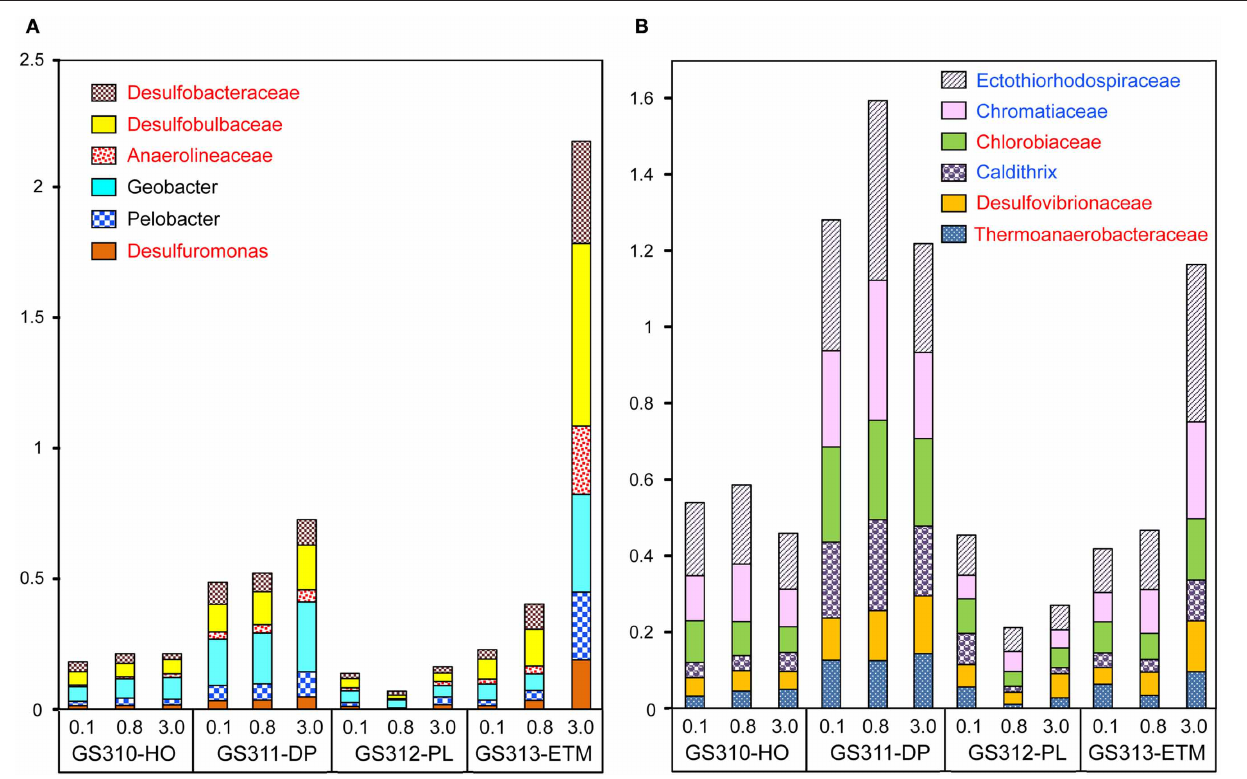
deep water samples. (B) Genera and families that are enriched to a similar degree in the deep ocean and ETM metagenomes. Taxa shown in red lettering are characterized as strict anaerobes. Taxa shown in blue lettering are characterized as denitrifying bacteria. Sample names are encoded as described in the legend for Figure 3